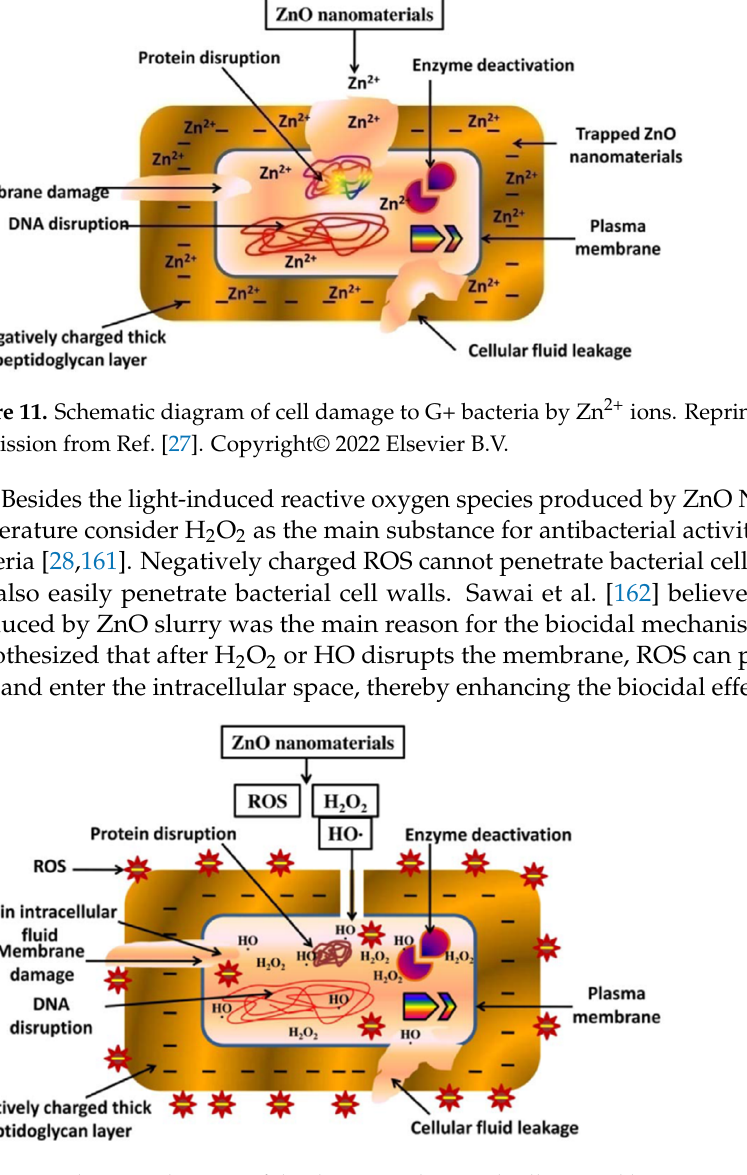
Figure 12. Schematic diagram of the damage to bacterial cells caused by ZnO nanomaterials producing H 2 O 2 . Reprinted/adapted with permission from Ref. [27]. Copyright© 2022, Elsevier B.V.